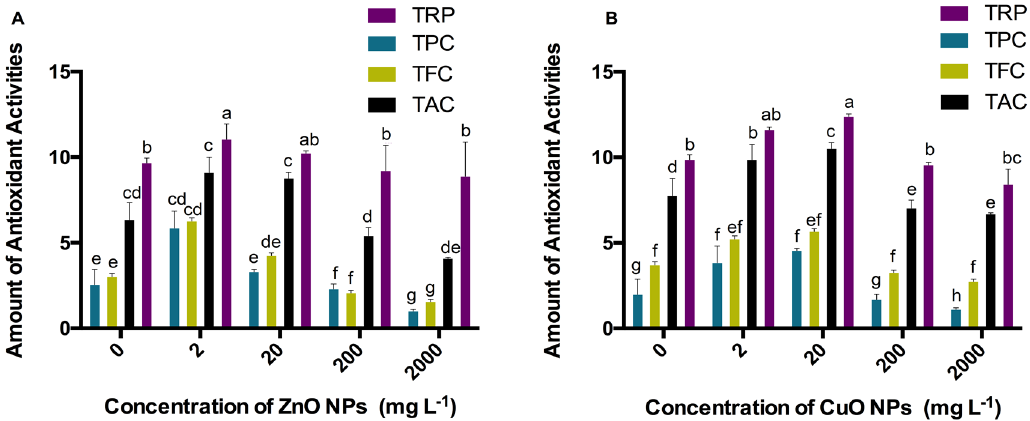
Figure 4. ( A ) E ff ect of ZnO ENPs and ( B ) e ff ect of CuO ENPs at di ff erent concentrations ranging Figure 4. ( A ) Effect of ZnO ENPs and ( B ) effect of CuO ENPs at different concentrations ranging between 0 and 2000 mg / L on di ff erent antioxidant activities. Di ff erent letters indicate di ff erences between 0 and 2000 mg/L on different antioxidant activities. Different letters indicate differences according to the Duncan’s multiple range test ( p < 0.05). according to the Duncan´s multiple range test ( p < 0.05).